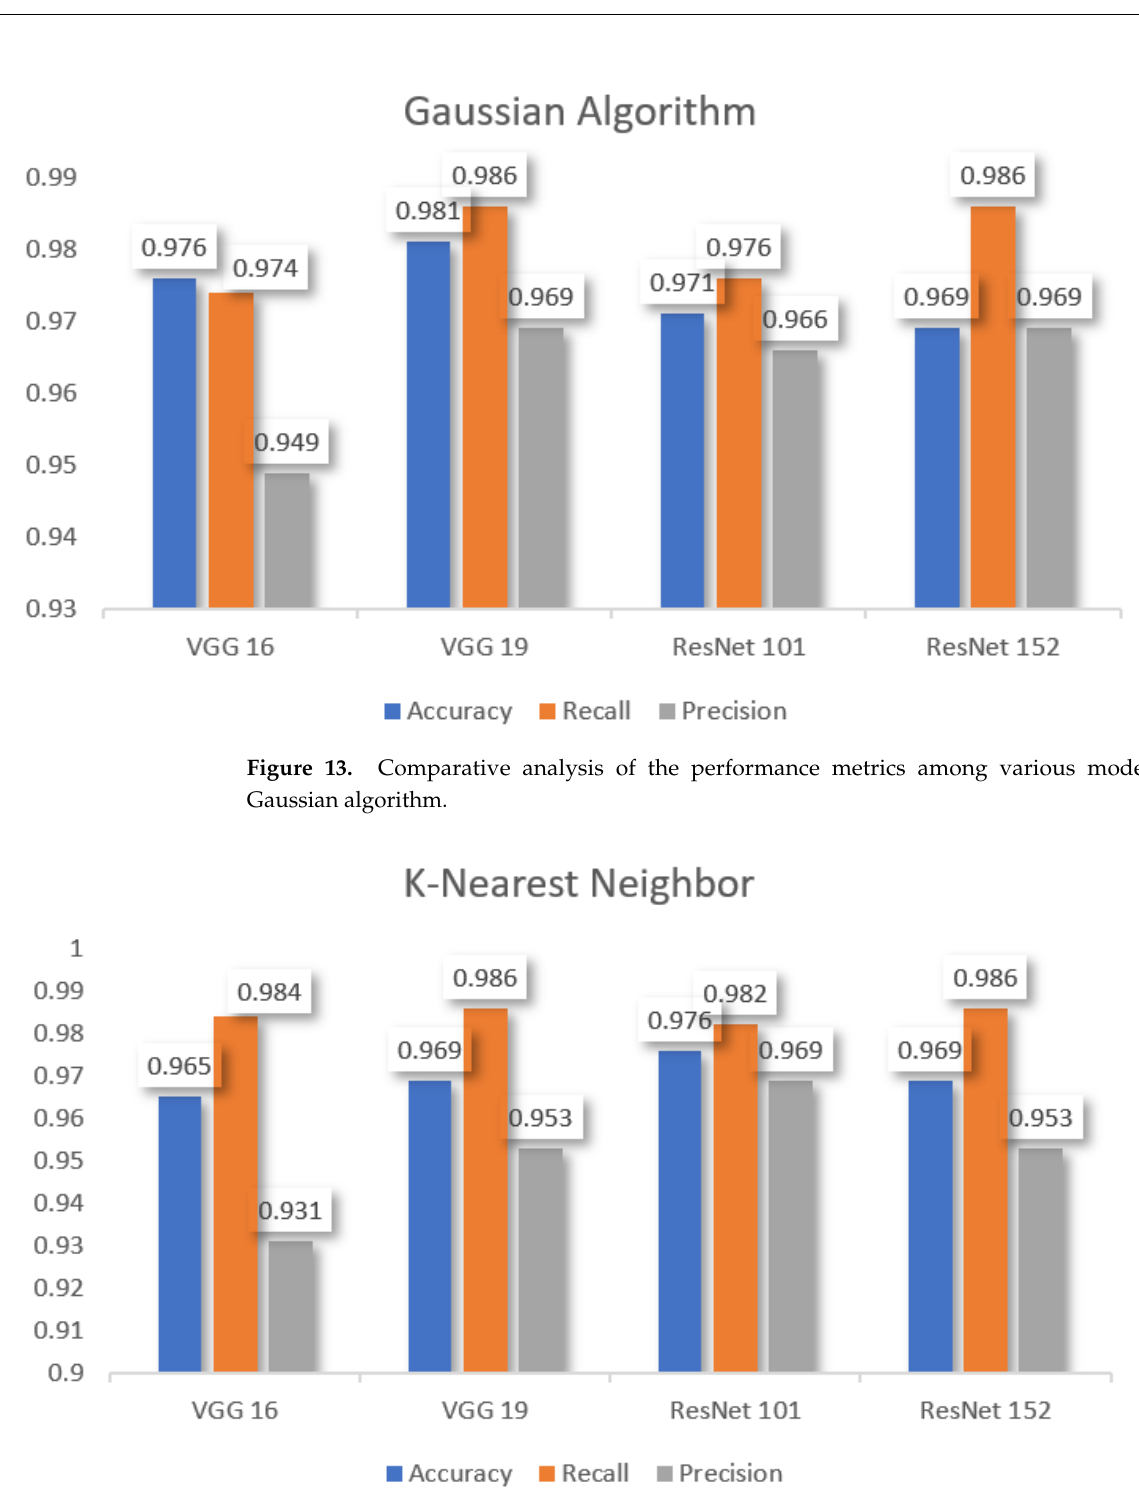
Figure 14. Comparative analysis of the performance metrics among various models using k-nearest neighbor (KNN).